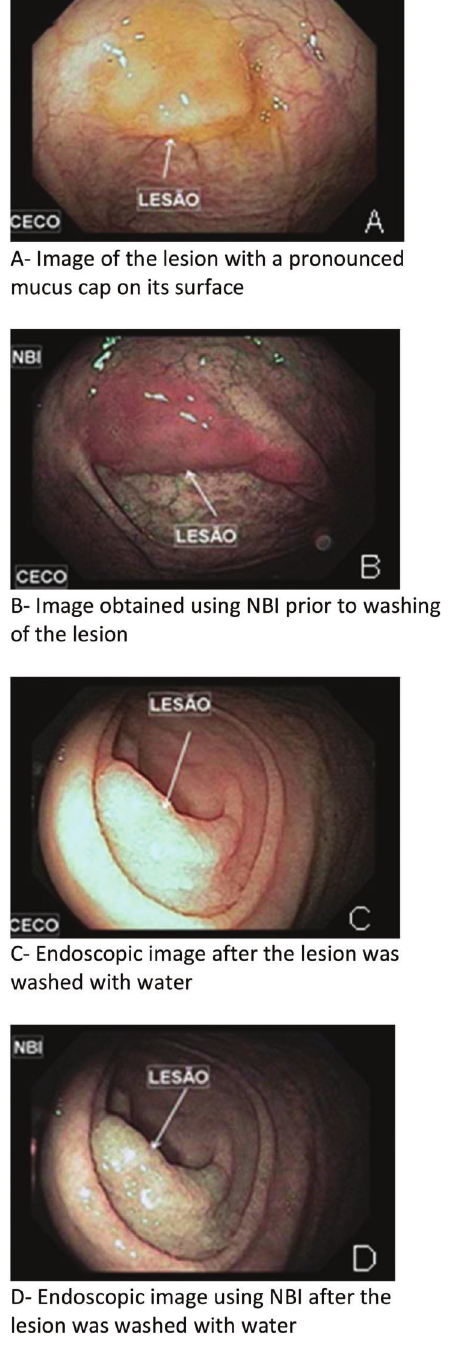
Figure 1 - Serrated adenoma in the cecum.